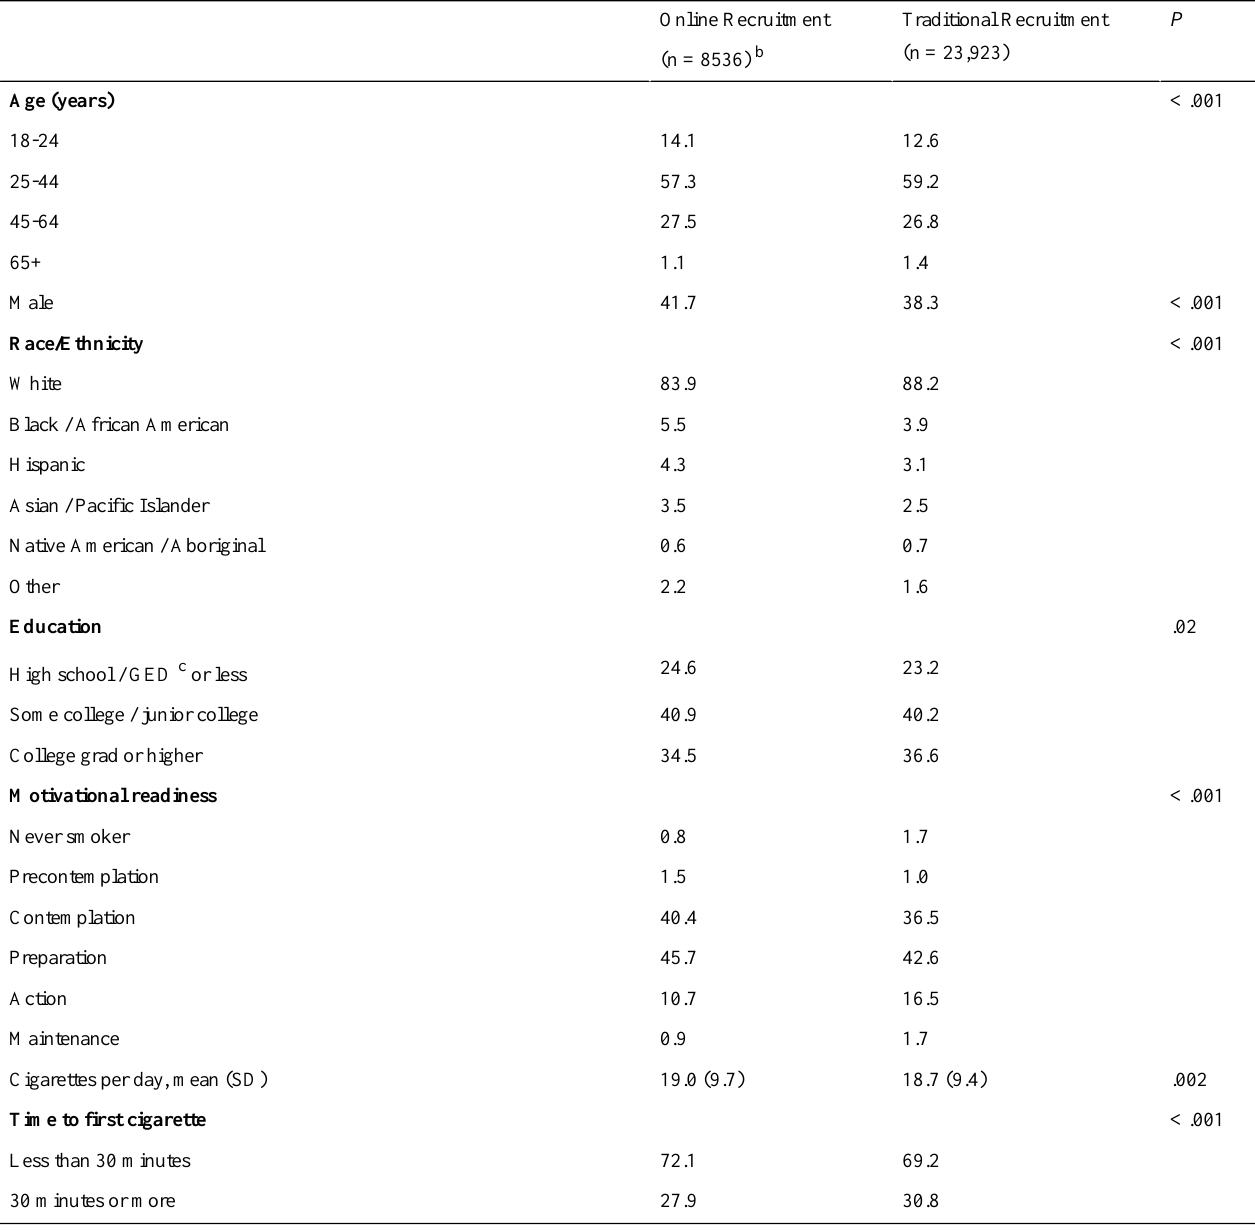
Table 1. Online vs traditional recruitment: demographic and smoking characteristics a